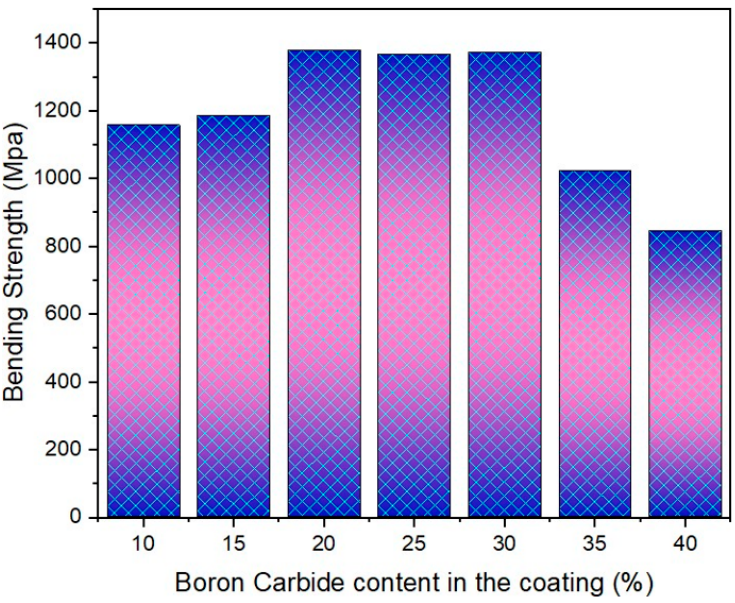
Figure 12. The matrix for maximum bending strength and various coatings of B 4 C /Ni63.